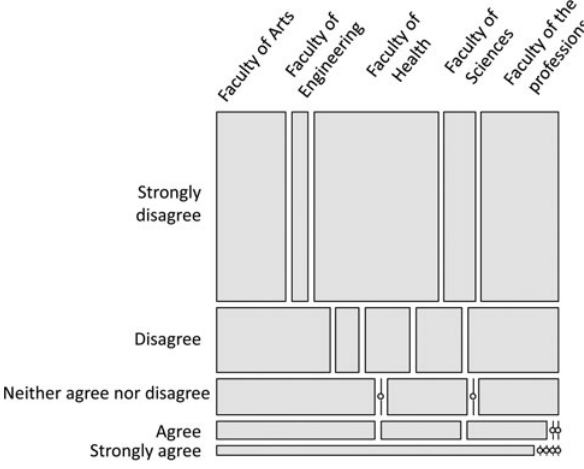
Fig. 4. Mosaic plot representing the association between faculty and withdrawal